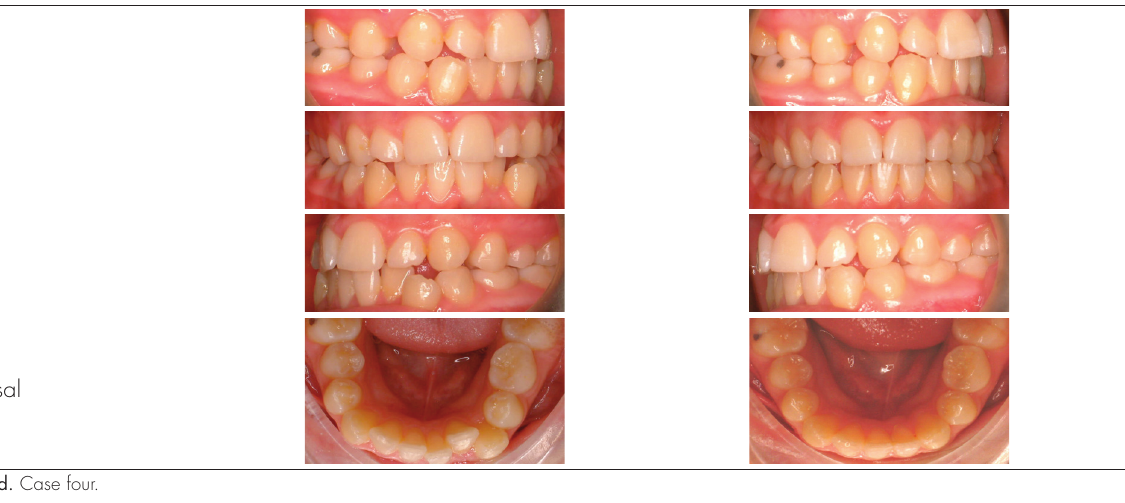
Figure 2c. Case three.